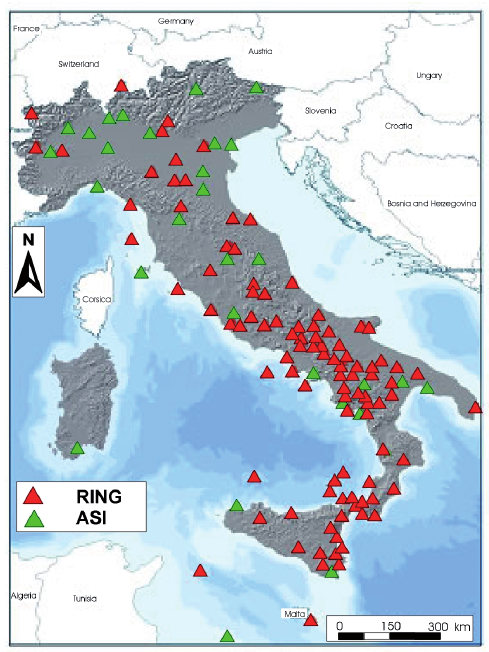
Fig. 5. The Ring Network at 2007 (in green ASI stations) (courtesy of Dr. G. Selvaggi,